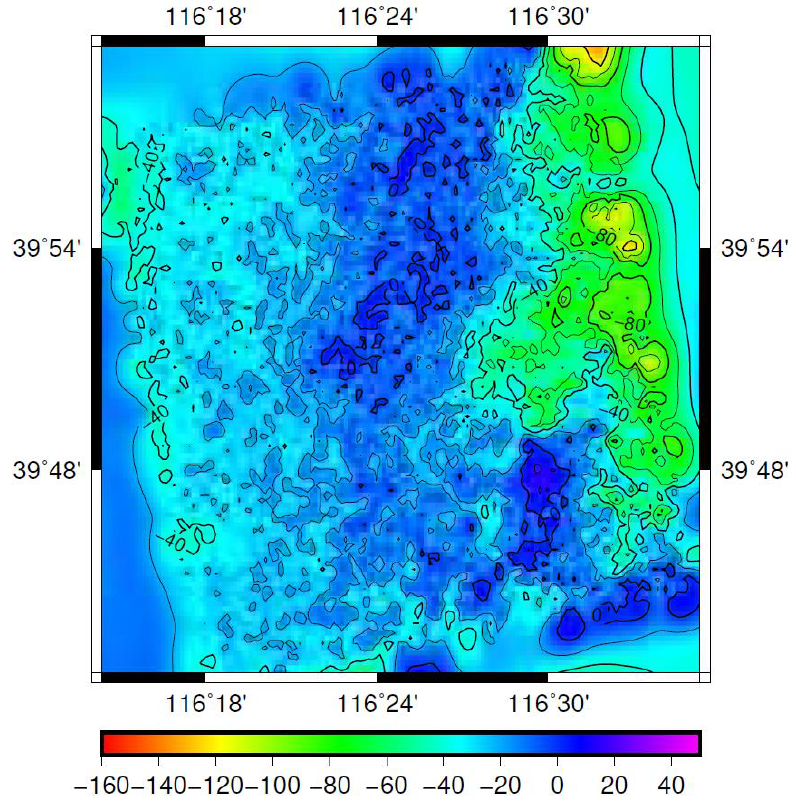
Figure 6. Contour